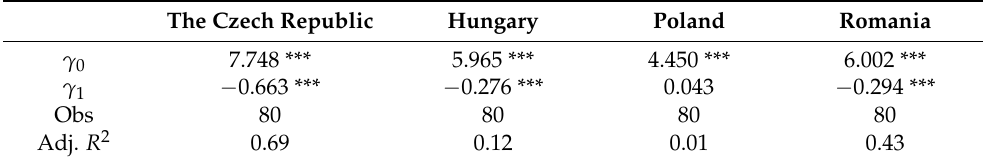
Table 8. Estimates of the RER adjusted for the level of